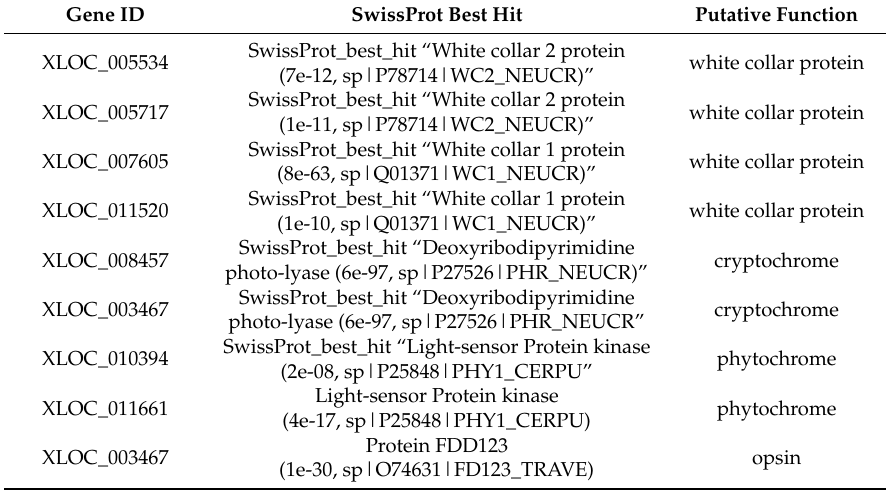
Table 2. Transcripts encoding putative photoreceptors identified in C. unicolor transcriptome during fungus growth in the different lighting conditions.